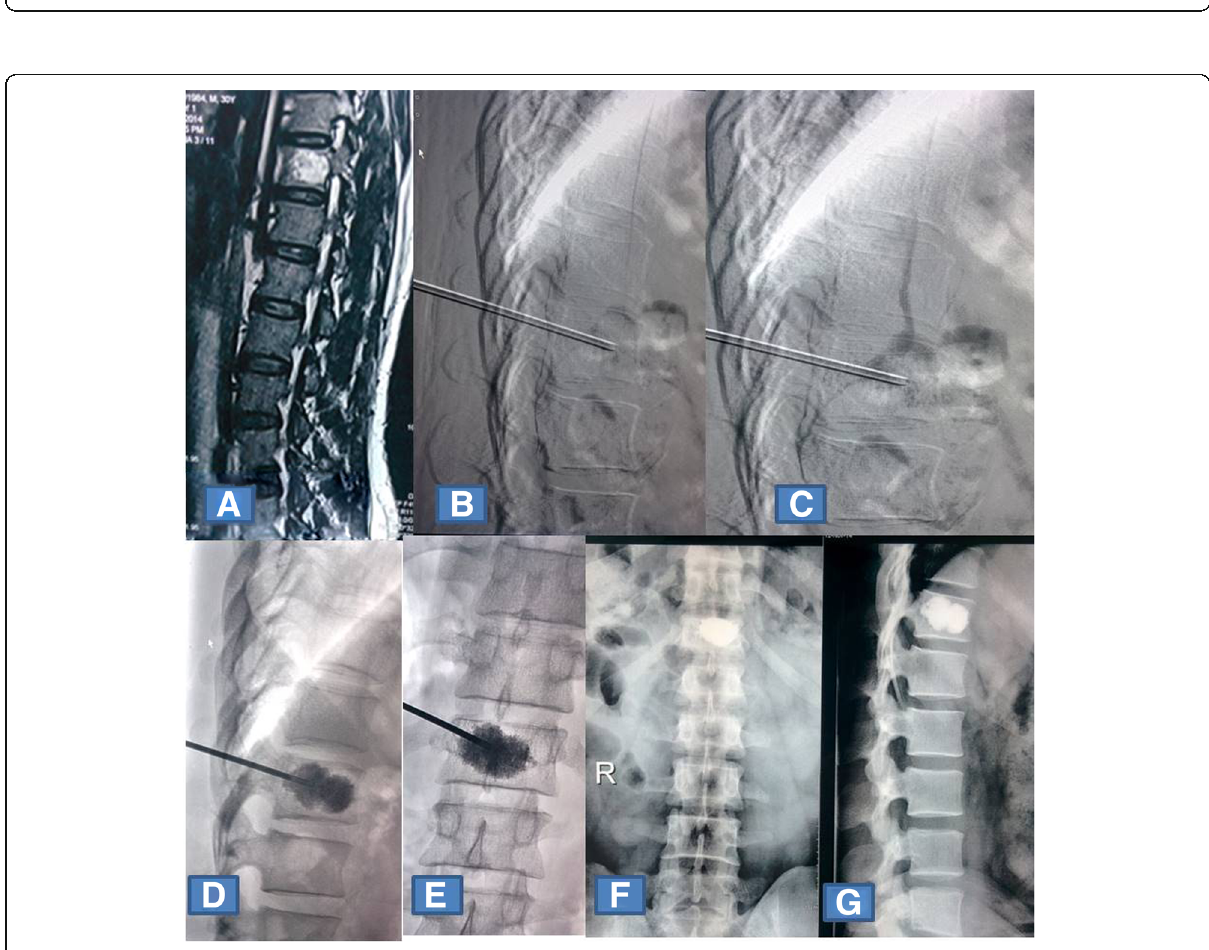
Fig. 2 A-30-year-old male patient presented with back pain since last 1 year seldom radiating to left lower leg. a MRI T2WI shows a vertebral hemangioma in D12 vertebral body. b DSA image lateral view showing transpedicular approach of needle placement at junction of anterior one third and posterior two third. c DSA image lateral view showing paravertebral venous plexus when contrast was injected so a thicker bone cement paste was used to prevent venous extension of cement. d , e DSA images showing adequate filling of vertebral body by cement. f , g Post-vertebroplasty X-ray image shows good filling of bone cement in the body of D12 vertebra. On follow-up, at 1 week, there was significant pain